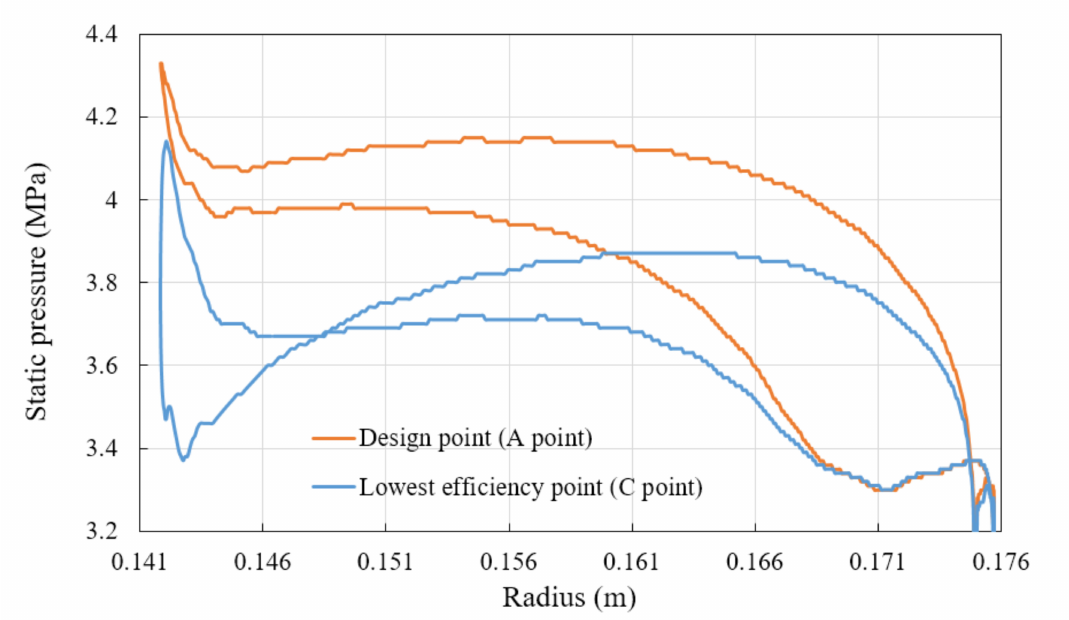
Figure 17. Blade loading chart according to the radius of rotor blade (A point and C